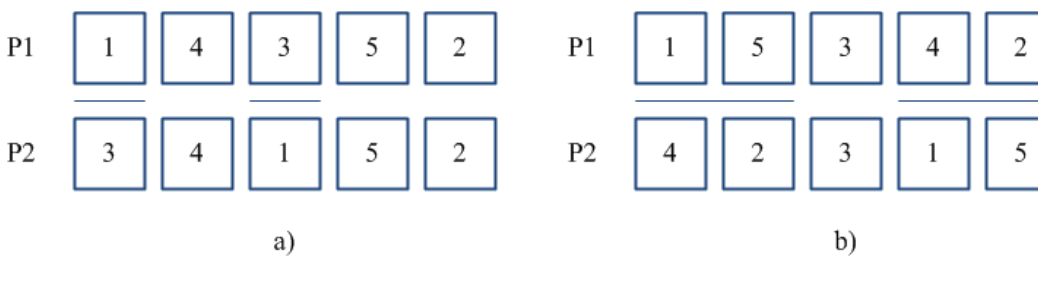
Figure 5. ( a ) Allele Swapping (ASO); and ( b ) Block Swapping (BSO) mutation